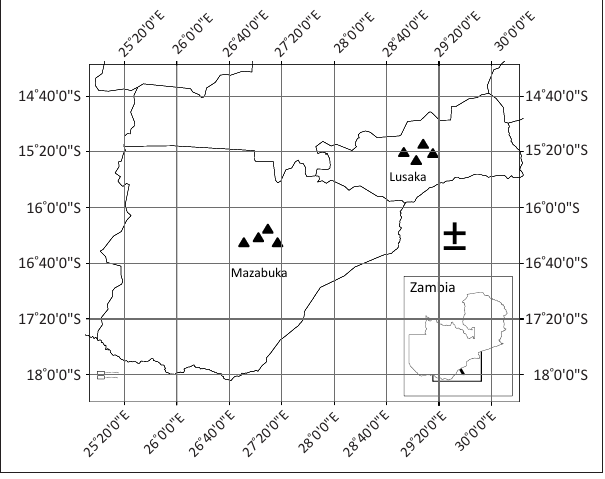
their comparison with other strains. The sequences of